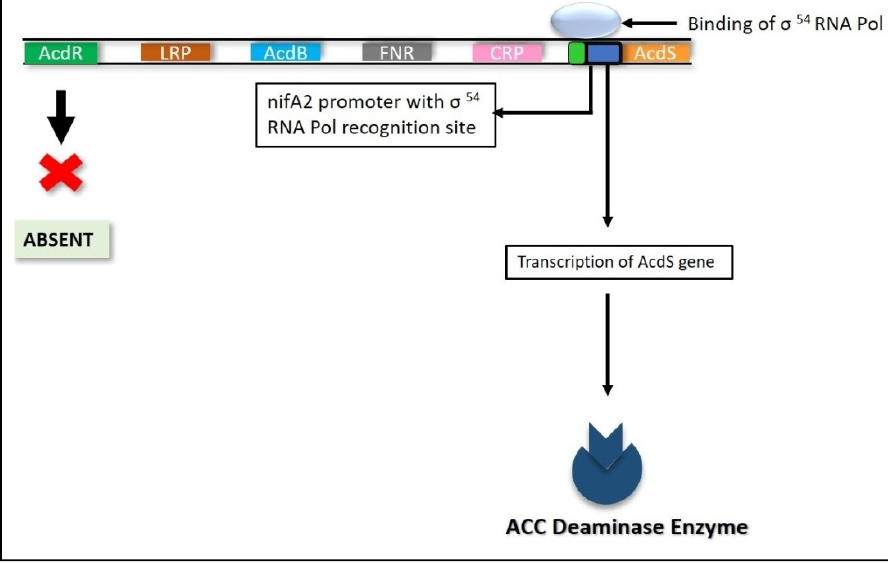
Figure 7. Regulation of acdS gene by nifA2 promoter.